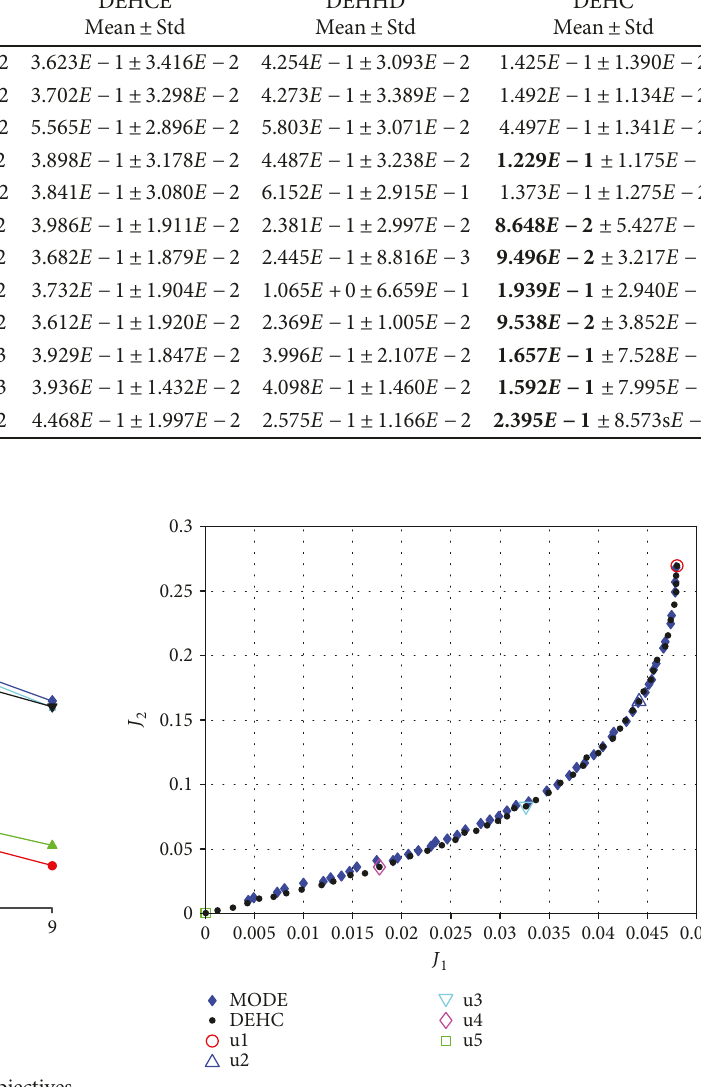
Figure 12: The Pareto optimal front for case I. Table 5: Five solutions selected from the front for case